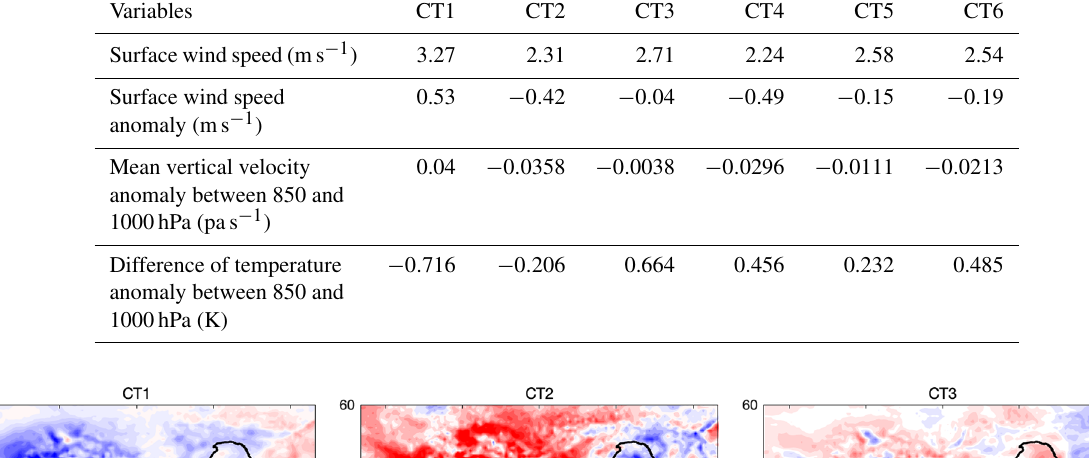
Table 2. Regional mean meteorological variables over the BTH region under each circulation type.